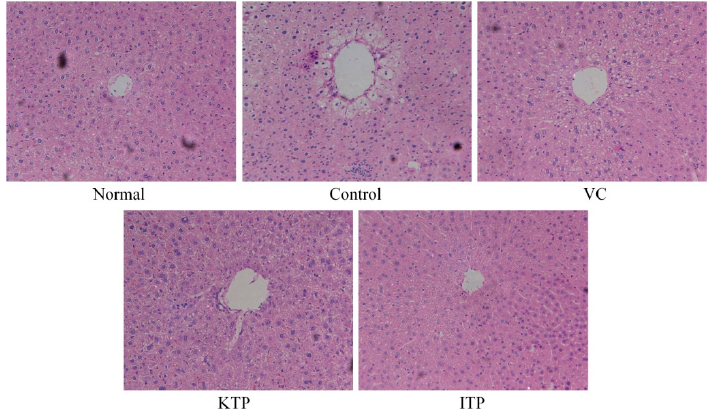
Figure 2. H&E pathological observation of liver in mice. Magnification 100×. VC: vitamin C (200 mg/kg body weight); KTP: Kuding tea polyphenols (200 mg/kg body weight); ITP: insect tea polyphenols (200 mg/kg body weight).